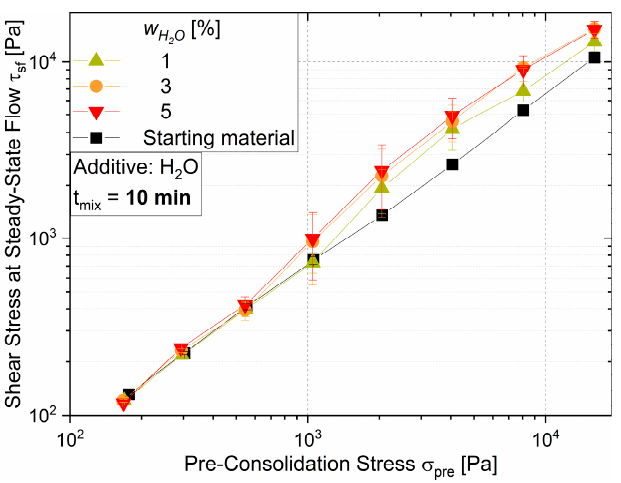
Figure 5. Mean shear stress at steady-state flow in dependence of the pre-consolidation stress for coarse sand as well as mixtures of coarse sand and water at: w H2O = 1%, w H2O = 3% and w H2O = 5%. Noticeably, the shear stress of mixtures containing water does not deviate signifi- cantly from the values of the dry material at low consolidation stress. Mixtures containing stress, which may be due to a lubricating effect between particles caused by liquid. These deviations are, however, minor in comparison to the effects at higher normal stress. The shear stress increases considerably at normal stresses of σ ≥ 1 kPa for mixtures with w H2O ≥ 3%, whereas increased shear stress is postponed for the mixture with the lowest water content of w H2O = 1%. Assuming water only resides on outer particle surfaces, higher nor- mal stress consolidates the bulk solid and, consequently, forces the liquid downward be- tween particles, thereby resulting in a higher water concentration within the given vol- ume. Hence, tensile forces are presumably higher in the lateral direction and, thus, adhe- sive forces between particles increase. The shear stress increases accordingly under suffi- cient normal stress. For higher water contents, an increase in shear stress may occur at lower normal stress as a result of the degree of saturation within the bulk material, which, in turn, additionally increases when the bulk material is further consolidated. Cohesion- less bulk materials are assumed to have a near linear progression that runs through the origin. However, similar nonlinearities were observed in previous studies once the Bond number, a dimensionless unit for cohesive strength, was increased [36]. Further insight can be gained by transferring the above-portrayed data into an angle of internal friction at steady-state flow, which results from the horizontal cutting plane of a bulk material during ring shear measurements. The angle of internal friction at steady- state flow φ sf is calculated from the arc tangent of the ratio of shear stress at steady-state, defined in Figure 5 as τ sf , to normal stress at pre-consolidation σ pre [31]. Figure 6a demon- strates the aforementioned angle of internal friction for different normal stresses of dry coarse sand and mixtures containing water and sand.